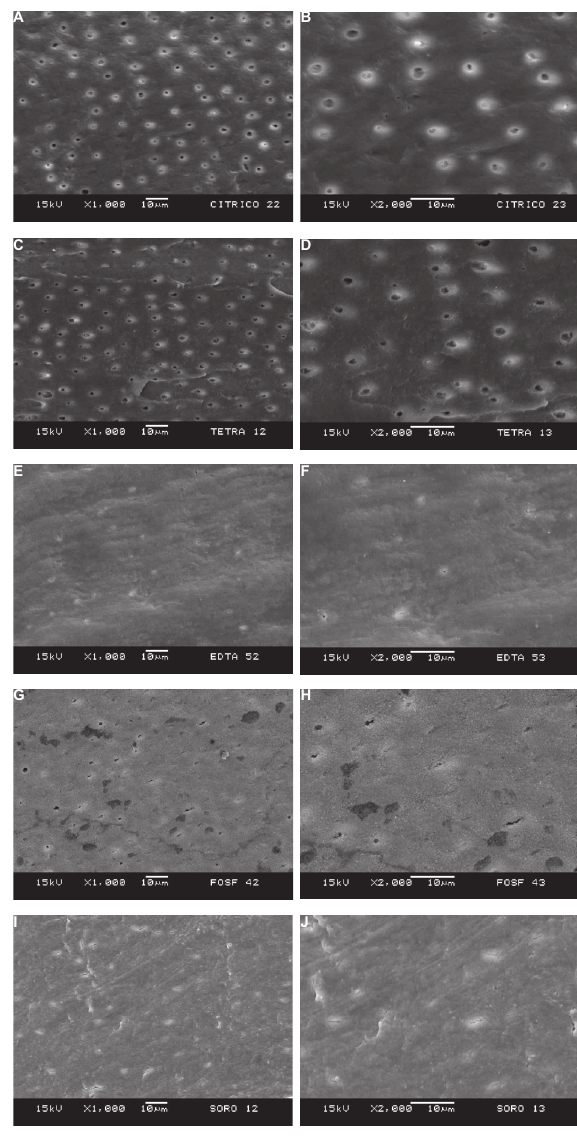
Figure 2- Panel of scanning electron microscopy (SEM) micrographs. A: representative specimen of the Ca group in which no smear layer can be noted and dentin tubules (cid:11)(cid:13)(cid:8)(cid:6)(cid:7)(cid:14)(cid:7)(cid:11)(cid:24)(cid:24)(cid:19)(cid:6)(cid:8)(cid:25)(cid:12)(cid:14)(cid:10)(cid:8)(cid:9)(cid:6)(cid:26)(cid:27)(cid:28)(cid:29)(cid:29)(cid:29)(cid:30)(cid:31)!(cid:6)"#(cid:6)(cid:21)(cid:28)(cid:29)(cid:29)(cid:29)(cid:30)(cid:6)(cid:22)(cid:11)(cid:20)(cid:16)(cid:4)(cid:17)(cid:5)(cid:11)(cid:7)(cid:4)(cid:14)(cid:16)(cid:6)(cid:14)(cid:15)(cid:6) the central part of A showing dentin tubules widened; C: representative specimen of the TC-HCl group at 1,000× showing absence of smear layer and exposed dentin (cid:7)(cid:23)(cid:18)(cid:23)(cid:24)(cid:8)(cid:10)!(cid:6)$#(cid:6)(cid:21)(cid:28)(cid:29)(cid:29)(cid:29)(cid:30)(cid:6)(cid:22)(cid:11)(cid:20)(cid:16)(cid:4)(cid:17)(cid:5)(cid:11)(cid:7)(cid:4)(cid:14)(cid:16)(cid:6)(cid:14)(cid:15)(cid:6)(cid:7)(cid:3)(cid:8)(cid:6)(cid:5)(cid:8)(cid:16)(cid:7)(cid:13)(cid:11)(cid:24)(cid:6)(cid:12)(cid:11)(cid:13)(cid:7)(cid:6)(cid:14)(cid:15)(cid:6)%(cid:6) showing widened dentin tubules; E: representative specimen of EDTA group presenting smear layer and few exposed (cid:7)(cid:23)(cid:18)(cid:23)(cid:24)(cid:8)(cid:10)(cid:6)(cid:26)(cid:27)(cid:28)(cid:29)(cid:29)(cid:29)(cid:30)(cid:31)!(cid:6)&#(cid:6)(cid:21)(cid:28)(cid:29)(cid:29)(cid:29)(cid:30)(cid:6)(cid:22)(cid:11)(cid:20)(cid:16)(cid:4)(cid:17)(cid:5)(cid:11)(cid:7)(cid:4)(cid:14)(cid:16)(cid:6)(cid:14)(cid:15)(cid:6)(cid:7)(cid:3)(cid:8)(cid:6)(cid:5)(cid:8)(cid:16)(cid:7)(cid:13)(cid:11)(cid:24)(cid:6)(cid:12)(cid:11)(cid:13)(cid:7)(cid:6) of E; G: representative specimen of PA group at 1,000× of